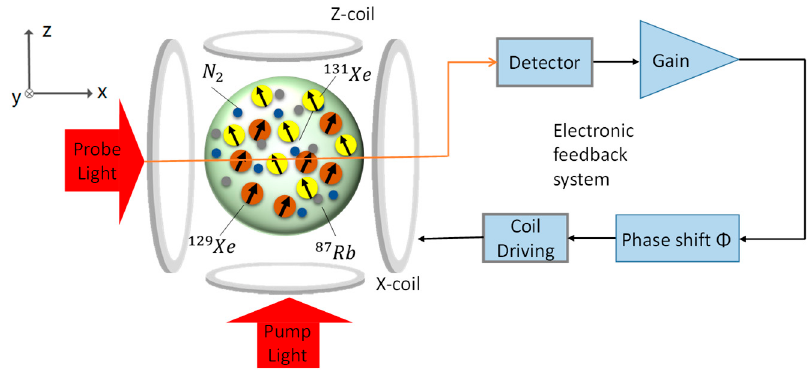
Figure 1. Principle of a dual-species spin oscillator.